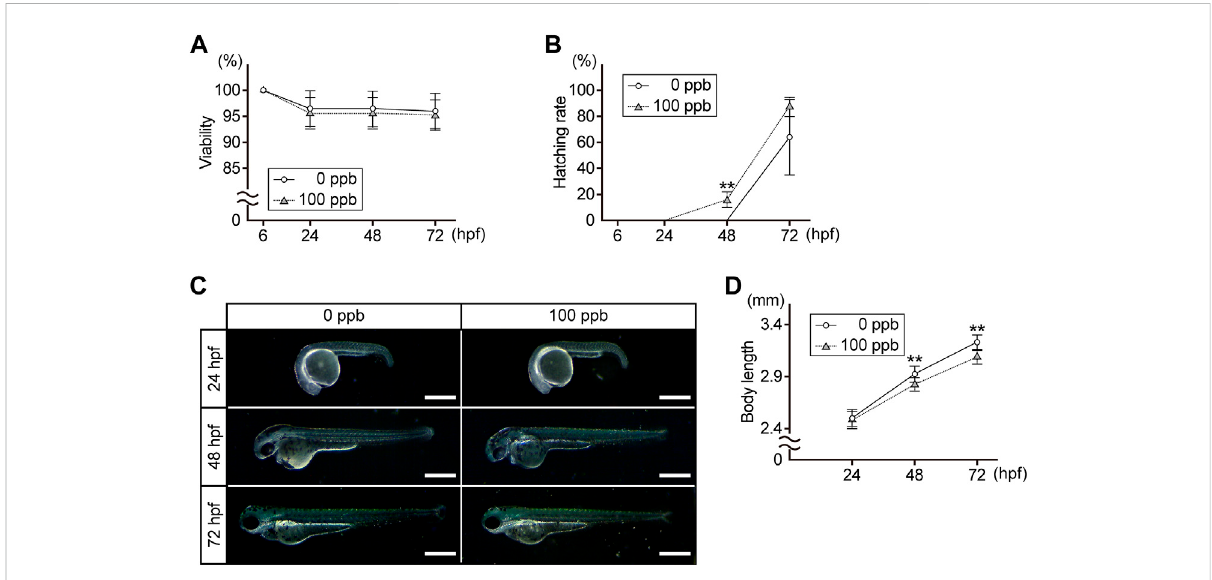
Viability, hatching rate, external morphology, and body length of the Pb-exposed (100 ppb Pb) and the control (0 ppb Pb) zebra fi sh embryos/ larvae. (A) viability, (B) hatching rate, and (D) body length are shown in the line charts. Circles (control) and triangles (Pb-exposed) with error bar represent the mean ±SD. (C) photographs are representative of three experiments and oriented anterior to the left and dorsal to the top. Scale bar = 500 μ m. (A,B,D) statisticalsigni fi cancebetweencontrolandPb-exposedgroupsateachtimepointwascalculatedbytheStudent ’ st-test.** p <